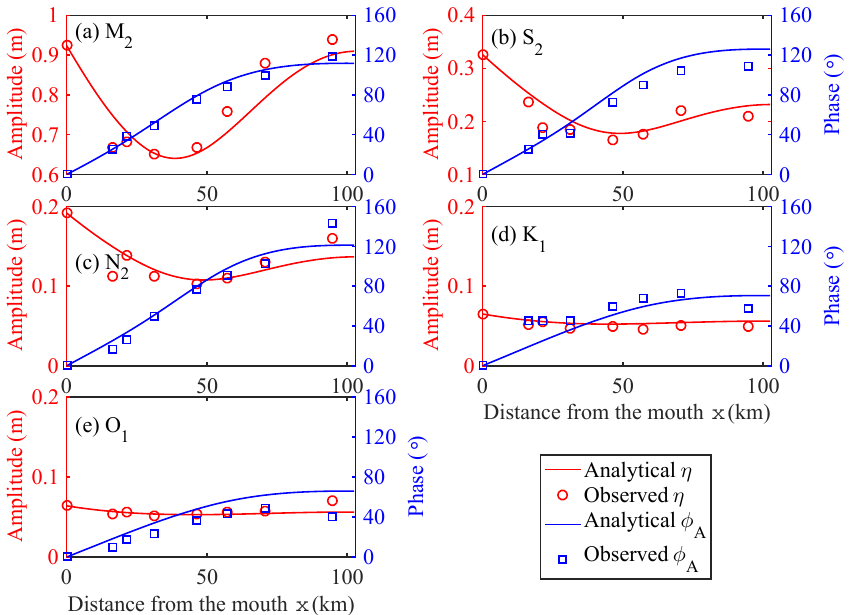
Figure 8. Tidal constituents (a) M 2 , (b) S 2 , (c) N 2 , (d) K 1 and (e) O 1 , modeled against observed values of tidal amplitude (m) and phase ( ◦ ) of elevation along the Guadalquivir estuary.